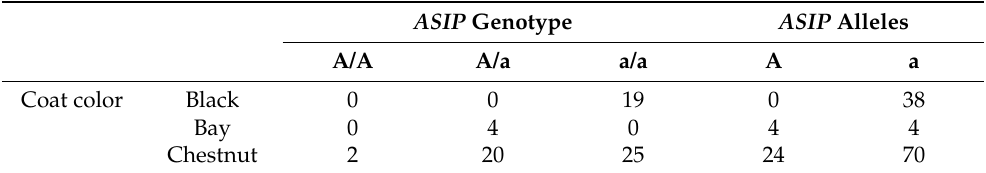
Table 2. Genotypes and alleles distribution of the ASIP polymorphism in the coat color phenotypes of the 70 genotyped Sarcidano Horse.